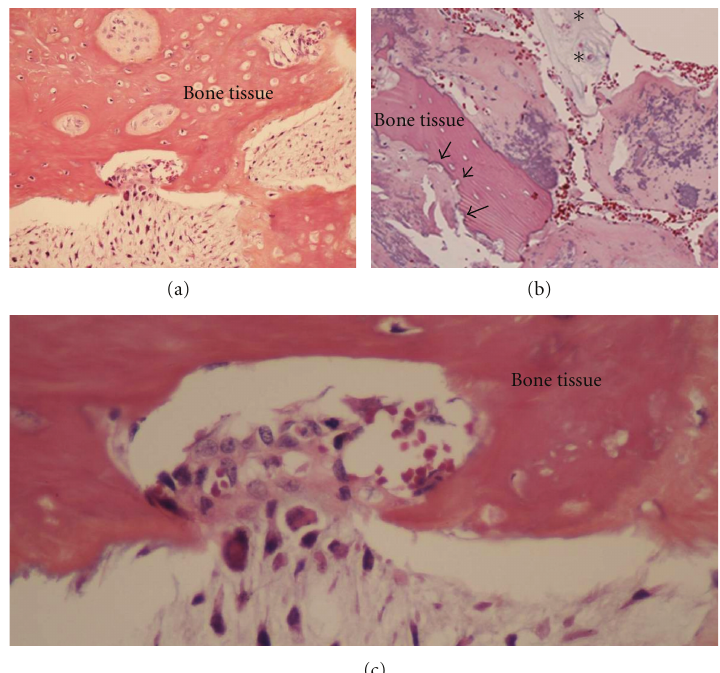
Figure 2: Chondrosarcoma growth is strongly linked to the bone tissue. Relationship between bone tissue and chondrosarcoma cells (a– c). Infiltration of chondrosarcoma cells into the bone tissue (permeation) (a–c). Chondrosarcoma development is associated with bone resorption foci (b). HES staining, original magnification ( × 20, a and b; × 40: c). Arrow: bone resorption area, arrow head: necrosis of chondrosarcoma tissue, and ∗ : viable tumour